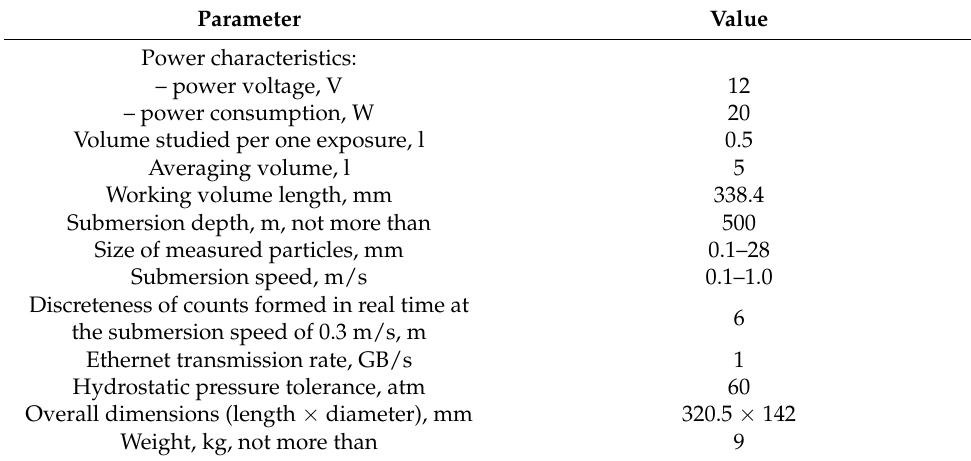
Figure 1. MiniDHC for accompanying measurements: ( a ) layout, ( b ) optical scheme. 1—mirror–prism system; 2—measured volume; 3—sealed case; 4—power connector; 5—Ethernet connector; 6—window; 7—beam expander; 8—receiving lens; 9—laser diode; 10—CMOS camera. Table 1. MiniDHC specifications